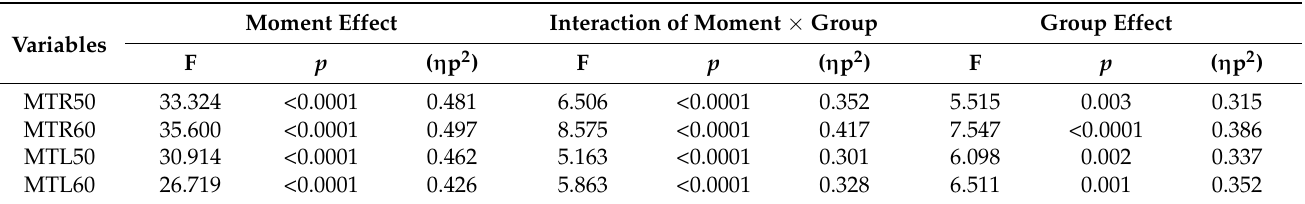
Table 2. Values of F, p and partial square eta ( η p 2 ) of the two factor repeated measures ANOVA analyses.